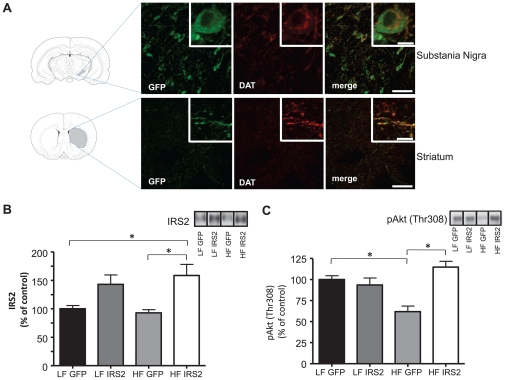
Viral-mediated expression of IRS2 in HF rats restores pAkt levels.Viral injection was performed as described in Methods. (A) Dopaminergic neurons from the substantia nigra (top row) and projection terminals in the striatum (bottom row) were probed for GFP and DAT after injection of HSV-GFP into the substantia nigra. The first column (green) represents GFP, the second column (red) DAT, and the third column represents the merging of these channels together to demonstrate co-expression in the same cell type (scale bars: 10 µm inset; 50 µm main panels; representative of n = 6 for LF; n = 8 for HF). (B) Representative immunoblot and quantification of IRS2 levels in the substania nigra after injection of either HSV-GFP or HSV-IRS2 in LF and HF animals (n = 4 per each group, *p<0.05 by one-way ANOVA, followed by Bonferroni post hoc test). (C) Representative immunoblot and quantification of pAkt (Thr308) levels in the substania nigra after injection of HSV-GFP or HSV-IRS2 in LF and HF animals. (LF, n = 3; HF, n = 4; *p<0.05 by one-way ANOVA, followed by Bonferroni post hoc test). All data are represented as mean ± S.E.M.